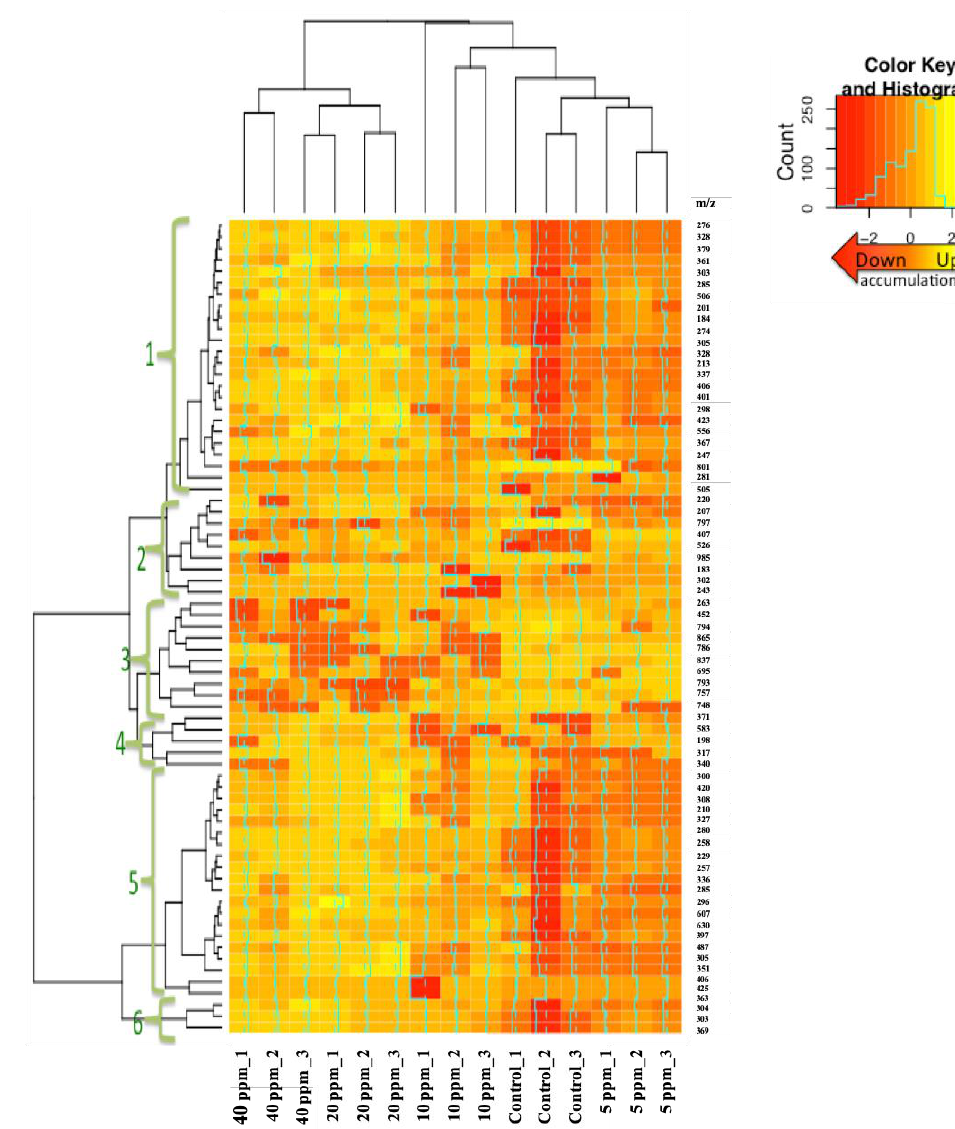
Figure 2. Hierarchical clustering analysis (HCA) of the metabolite levels (represented as mass-to-charge ratio ( m / z ) signal intensities) a ff ected by di ff erent doses of oligochitosan (O-80) treatment. The heat map shows the relative metabolite abundance for each replicate.